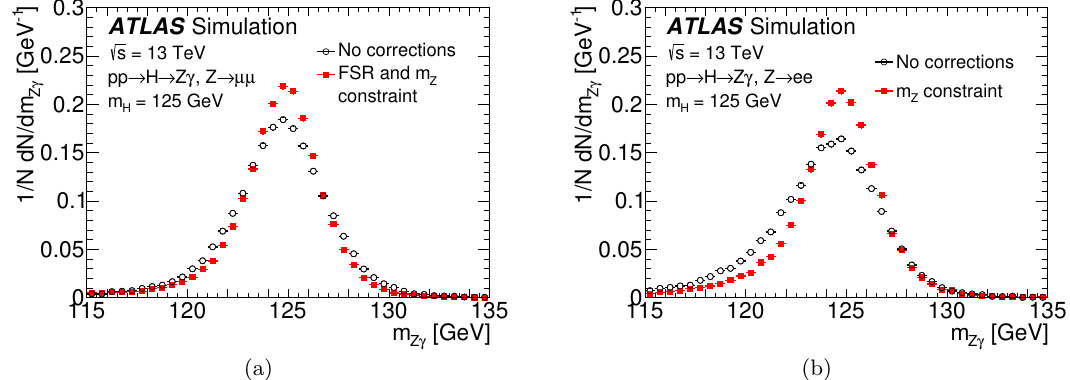
Figure 1 . Invariant mass distribution, m Z(cid:13) , for the (cid:12)nal selection before and after application of the (cid:12)nal-state radiation corrections ( Z ! (cid:22)(cid:22) only) and the Z boson mass constrained kinematic (cid:12)t for simulated H ! Z(cid:13) events with m H = 125 GeV in the gluon-gluon fusion production mode. Events are separated by lepton type, (a) Z ! (cid:22)(cid:22) and (b) Z ! ee . subtracted based on the method suggested in ref. [88]. The track isolation for a cone size of (cid:1) R = 0 : 2 is used and for converted photons the tracks associated with the conversion are removed. The calorimeter (track) isolation is required to be less than 6.5% (5%)